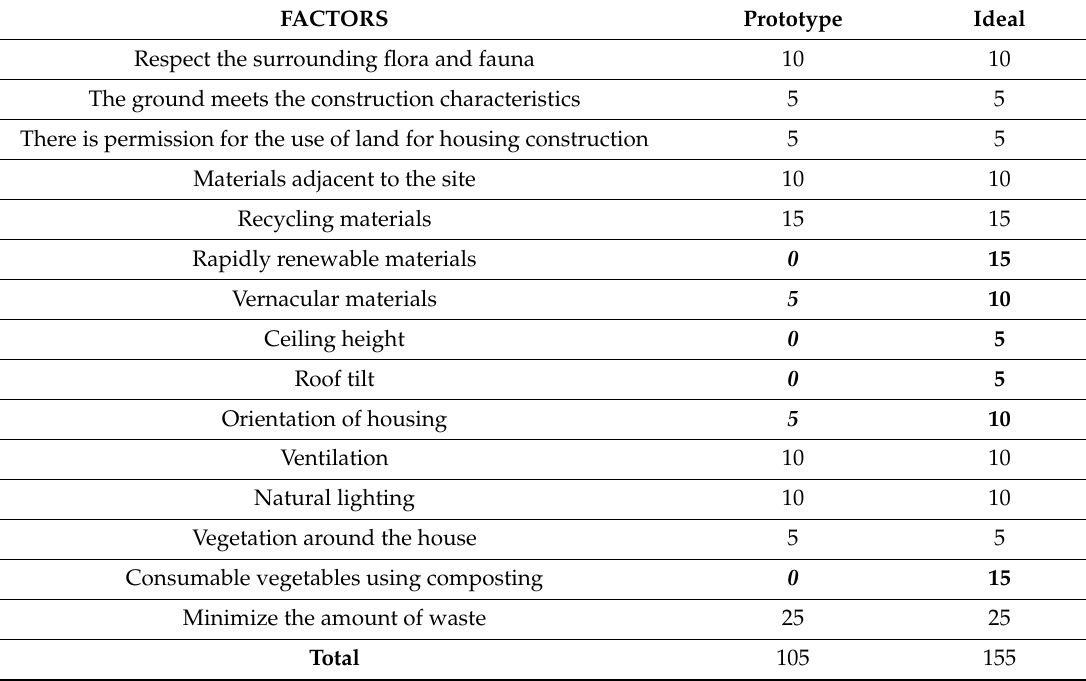
Table 3. Detailed prototype sustainability assessment for the construction